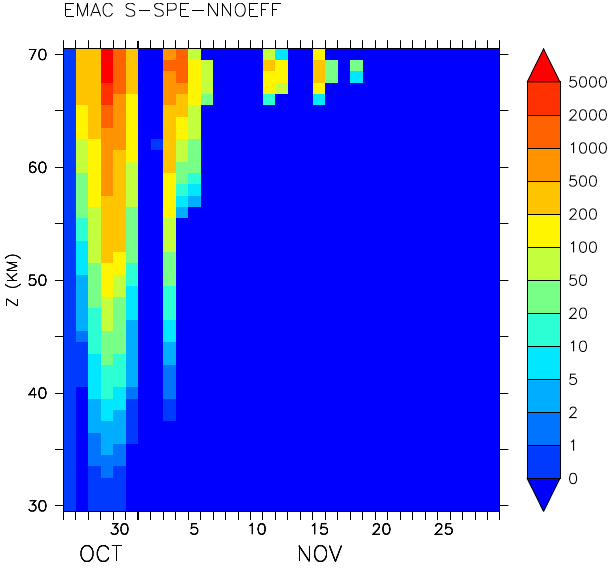
Fig. 14. Simulated change (pptv) of OH for 70–90 ◦ N with respect to 26 October